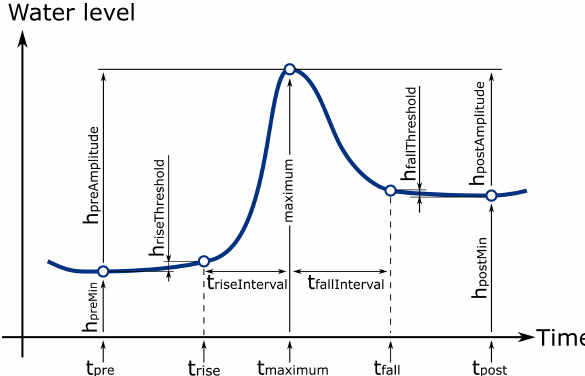
Figure 4. Event definition and characteristic variables for event re- sponse